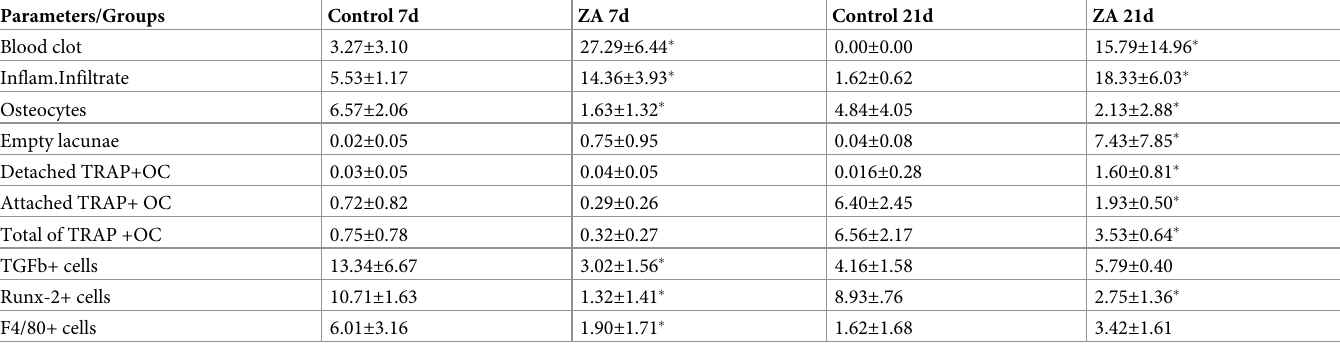
Table 1. Summary of quantitative results for histomorphometry of area density